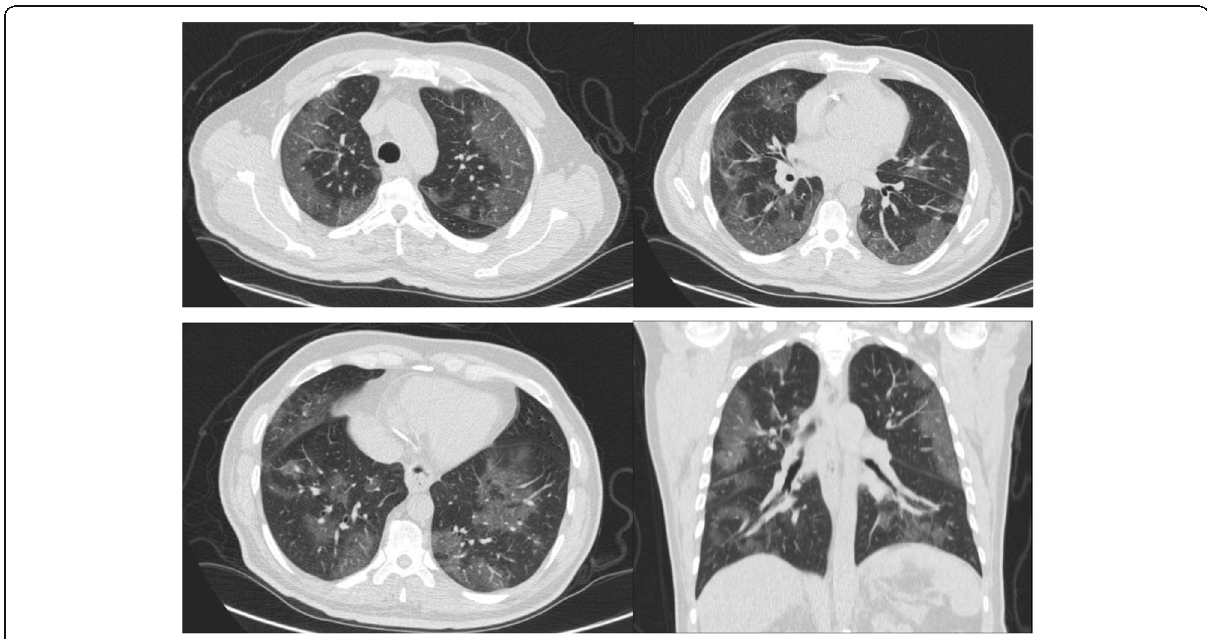
Fig. 1 COVID-19 pneumonia: thin section CT shows bilateral multifocal subpleural and peribronchial GGO, semiqutitative